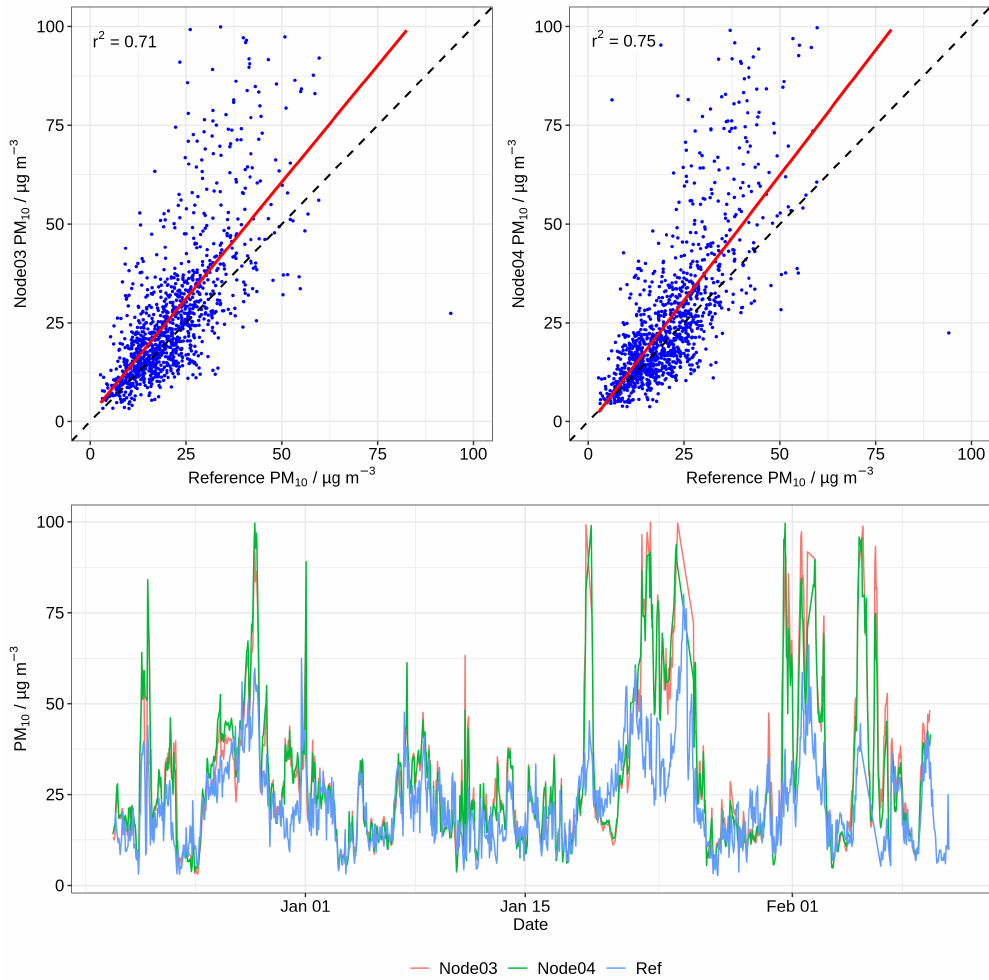
Figure A2. Correlation plots ( top ) for Node03 ( right ) and Node04 ( left ) versus reference measurements for the raw sensor output of PM 10 . A linear regression fit line (solid red line) and a 1:1 line (dashed black line) are shown in both panels. Time series (bottom) of two sensor nodes (Node03 and Node04) and reference air quality monitoring station. All data shown are 1 h average values.